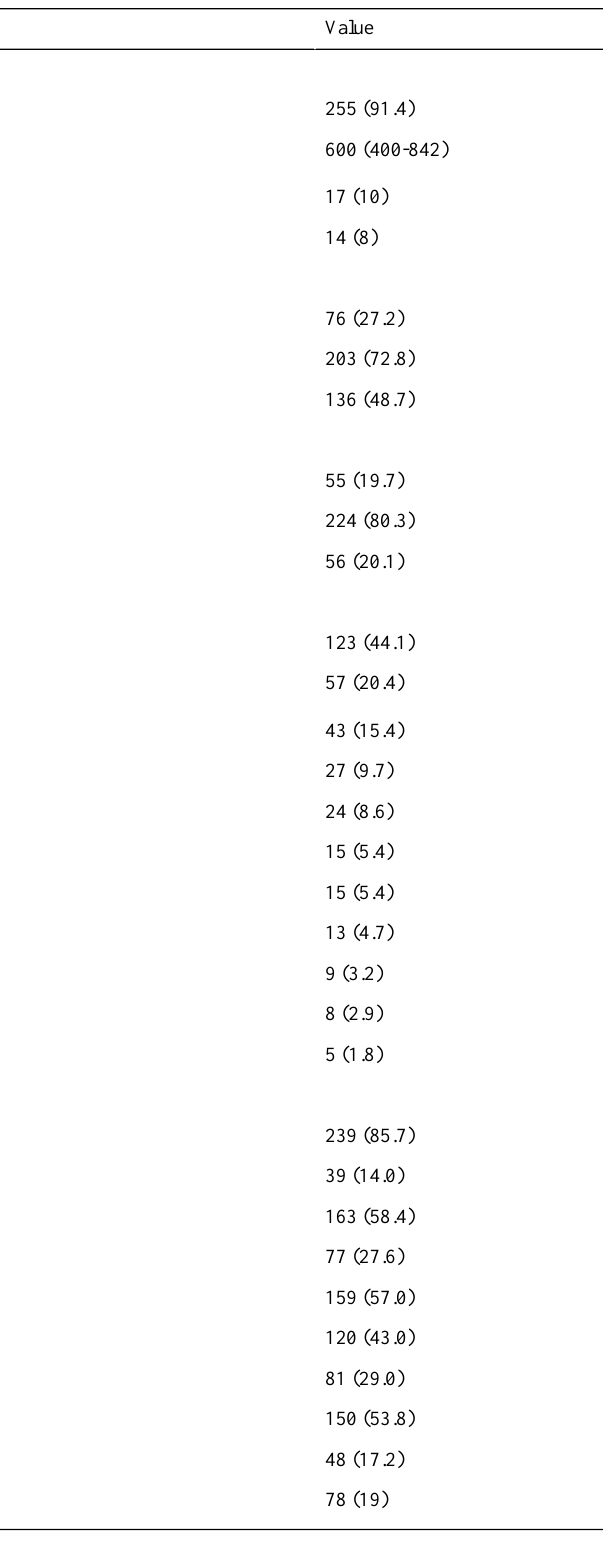
Table 2. Clinical and care path characteristics of people living with HIV